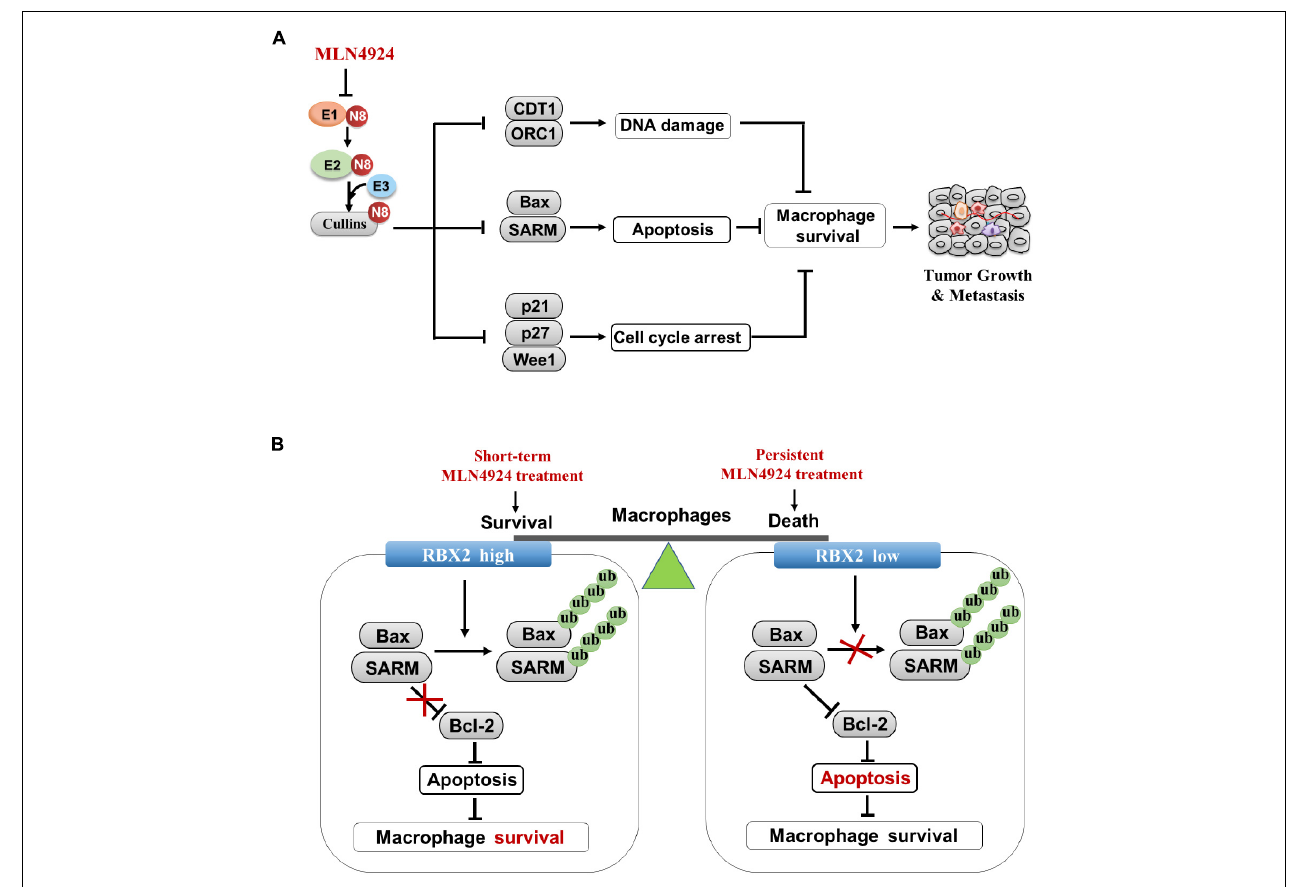
FIGURE 4 | Inhibition of neddylation pathway impairs proliferation and survival of macrophages. (A) Multiple anti-growth mechanisms in macrophages upon MLN4924 treatment. (B) Neddylation modification equilibrates the survival/inflammatory response and death of macrophages.